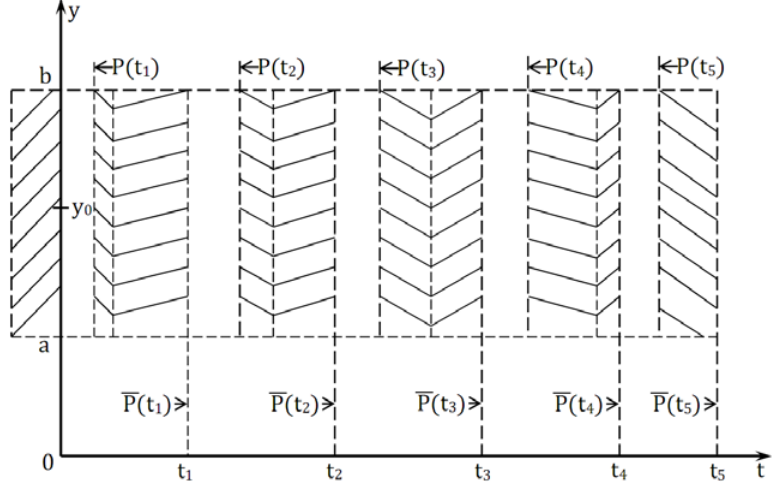
Figure 4. Graphic form depicting the probabilities 𝑃 —to reach the boundary and 𝑃(cid:3364) —not to reach the boundary.